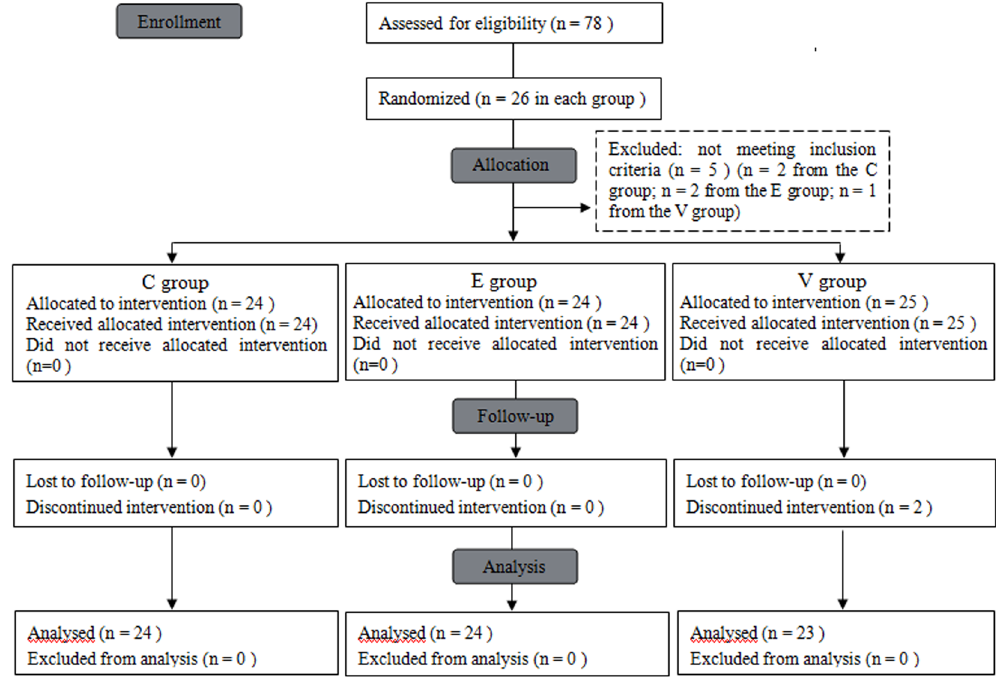
Figure 1. The study design and the flow of